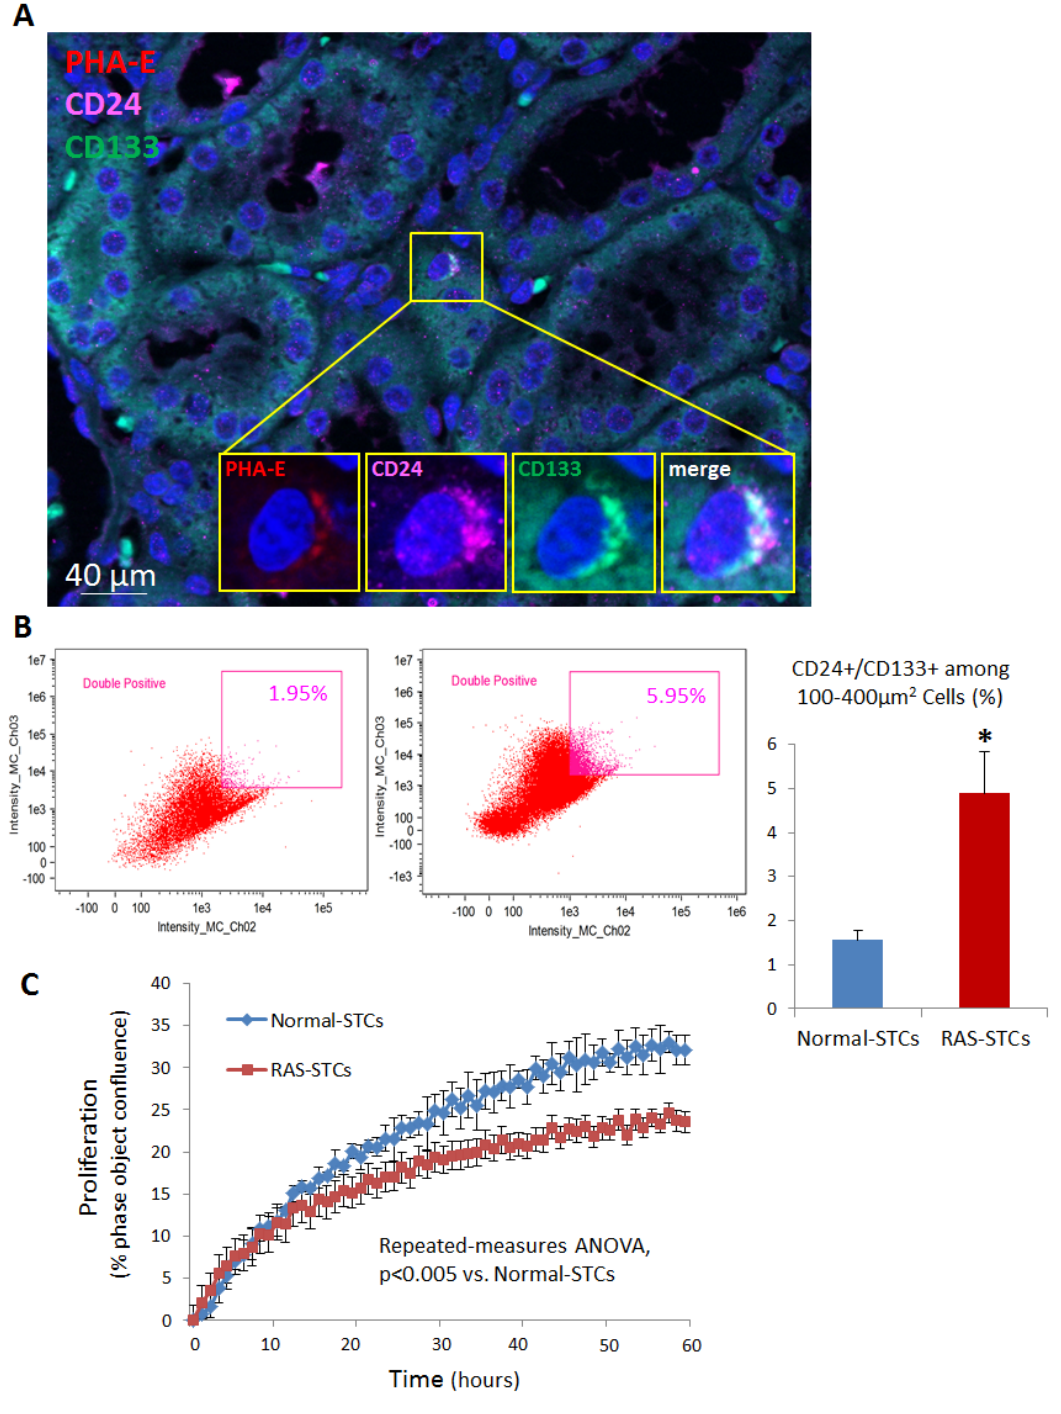
Figure 8. Scattered tubular-like cells (STC) activation and proliferation. ( A ) Representative immunofluorescence staining (40 X and 100 X ) for the STC surface markers CD133 (green) and CD24 (pink), and the tubular cell marker phytohemagglutinin (PHA)-E (red) showing CD133 +/ CD24 + cells in renal proximal tubules. ( B ) Flow cytometry analysis showing that the percentage of CD24 +/ CD133 + STCs from dissociated kidney cells was higher in RAS versus Normal pigs ( n = 3 each). ( C ) Cell proliferation, measured in percent phase object confluence unit, was impaired in RAS-STCs (Repeated-measures analysis of variance (ANOVA), n = 3 each). * p < 0.05 vs. Normal-STCs.